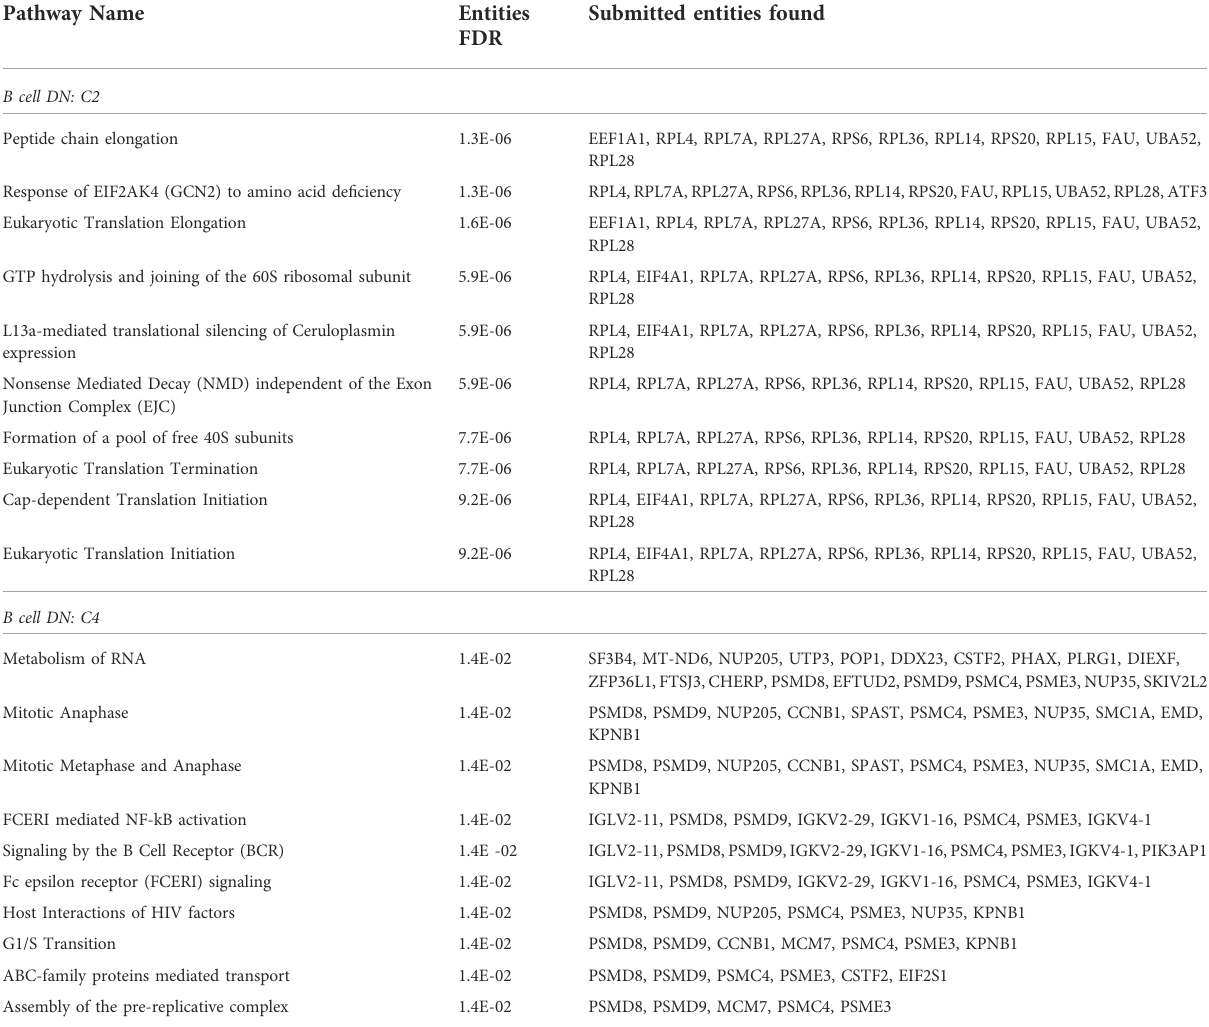
TABLE 2 Reactome pathway enrichment analysis. Statistically signi fi cant pathways are summarized for primary B cell DN community C2 and C4. In the full analysis, we omitted small communities with fewer than 8 genes Reimand et al. (2019); Gene Set Enrichment Analysis (2022), and 14 communities (C0 to C13) quali fi ed for the pathway